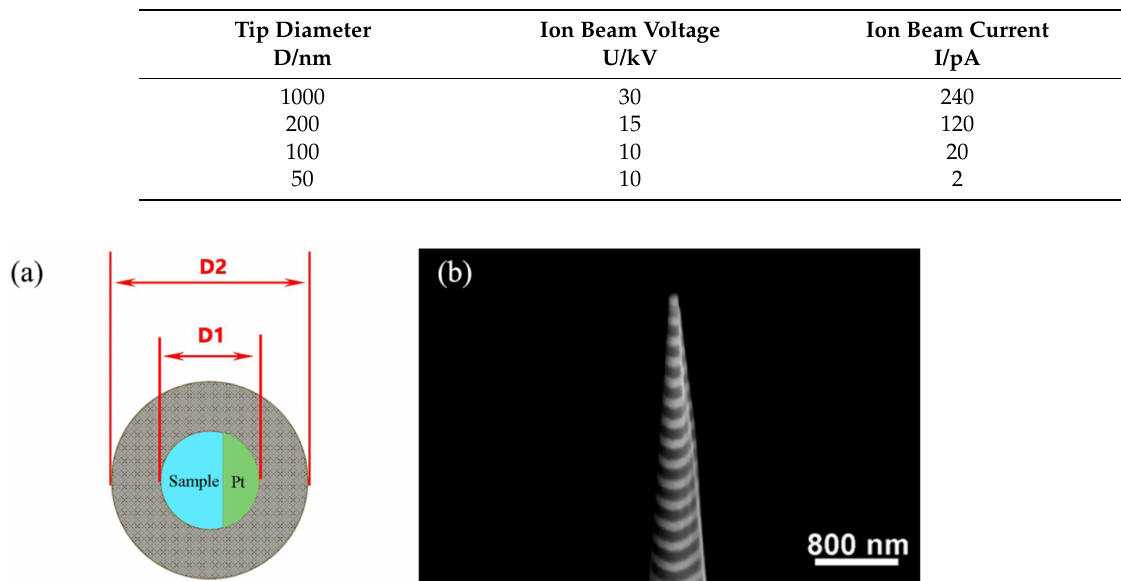
Table 1. The sample diameter versus FIB process parameter.